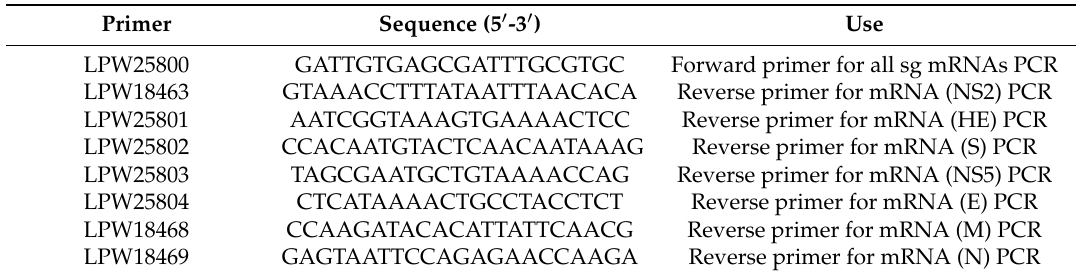
Table 2. Primers used for RT-PCR amplification of the leader-body junction of subgenomic mRNAs (sg mRNAs) of dromedary camel coronavirus